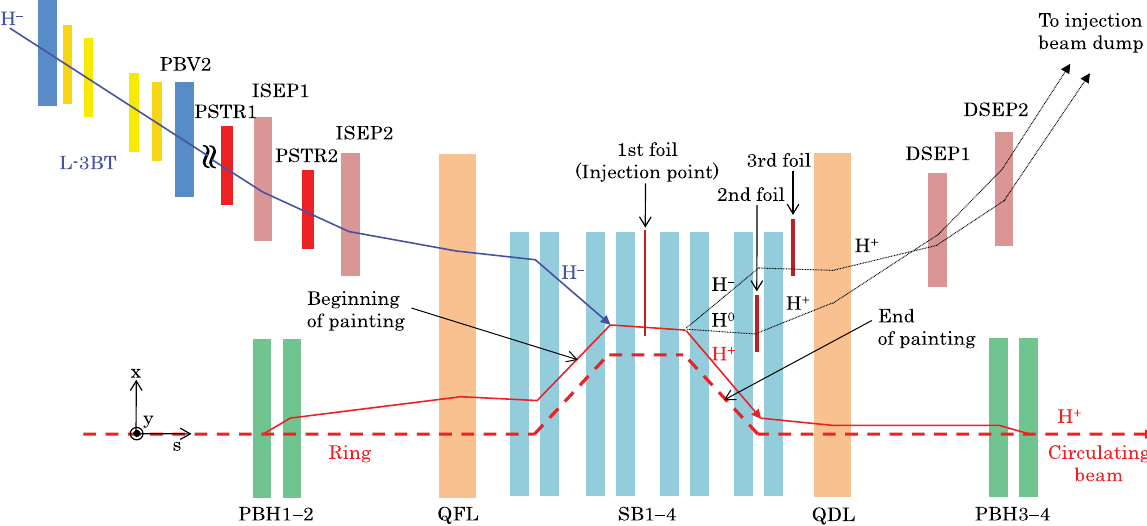
FIG. 4. Schematic view of the RCS injection area and demonstration of a transverse painting injection. In the horizontal direction, injected beam trajectory (blue line) is matched and fixed to the circulating orbit bump offset (red line) produced by the SB1-4 and PBH1-4 as indicated by ‘‘Beginning of painting’’. The injection painting is performed through sweeping circulating orbit bump offset by the PBH1-4 during 0.5 ms injection period to the red dashed line indicated by ‘‘End of painting’’. The SB1-4 is then linearly ramped down to zero so the closed orbit is moved to the ring center. However, for the center (no painting) injection, the red broken line is the orbit bump offset produced by the SB1-4. The injected beam trajectory as well as the first foil are then accordingly moved. There is no close orbit variation during injection as thus no transverse painting.